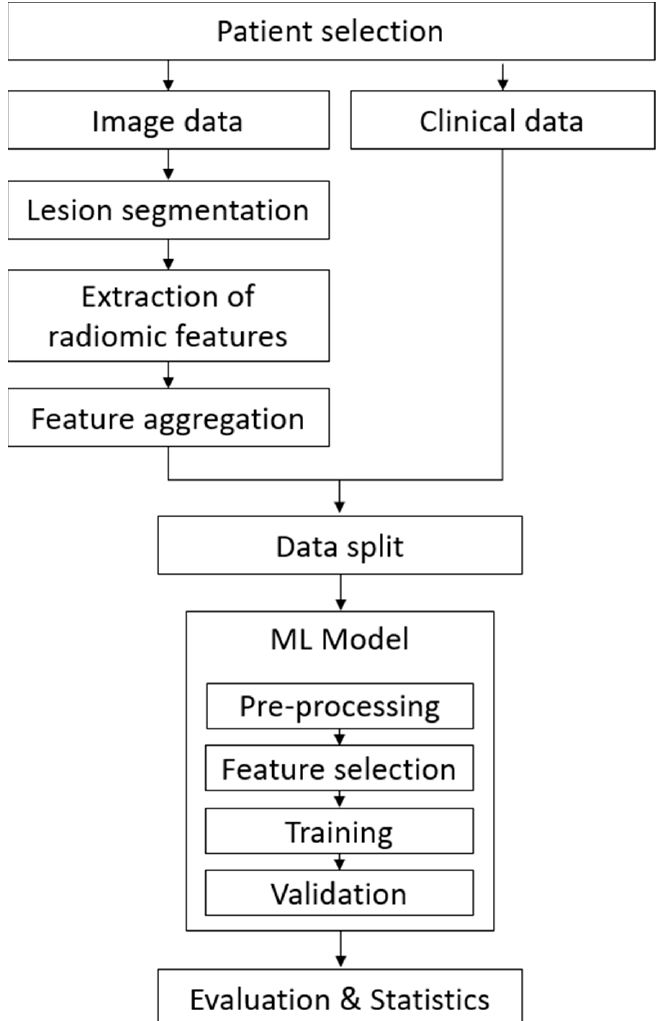
Figure 1. Schematic overview of the data processing and machine-learning workflow.